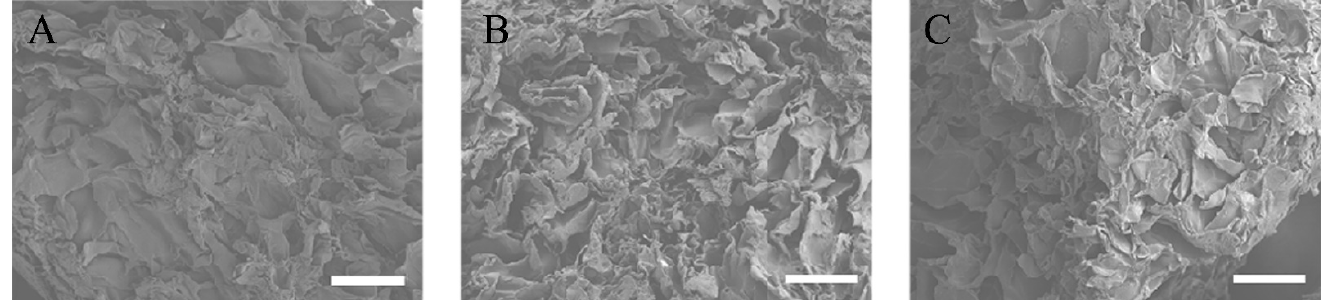
Figure 1. EPMA images of the three types of cross-linked RCP particles. Images taken with a field-emission electron probe microanalyzer (EPMA). Scale bars represent 100 μ m. ( A ) EPMA image of low cross-linked RCP particle. ( B ) EPMA image of medium cross-linked RCP particle. ( C ) EPMA image of high cross-linked RCP particle. Three types of RCP particles show similar pore sizes. Table 1. Characteristics and pore size of three types of cross-linked RCP particles.